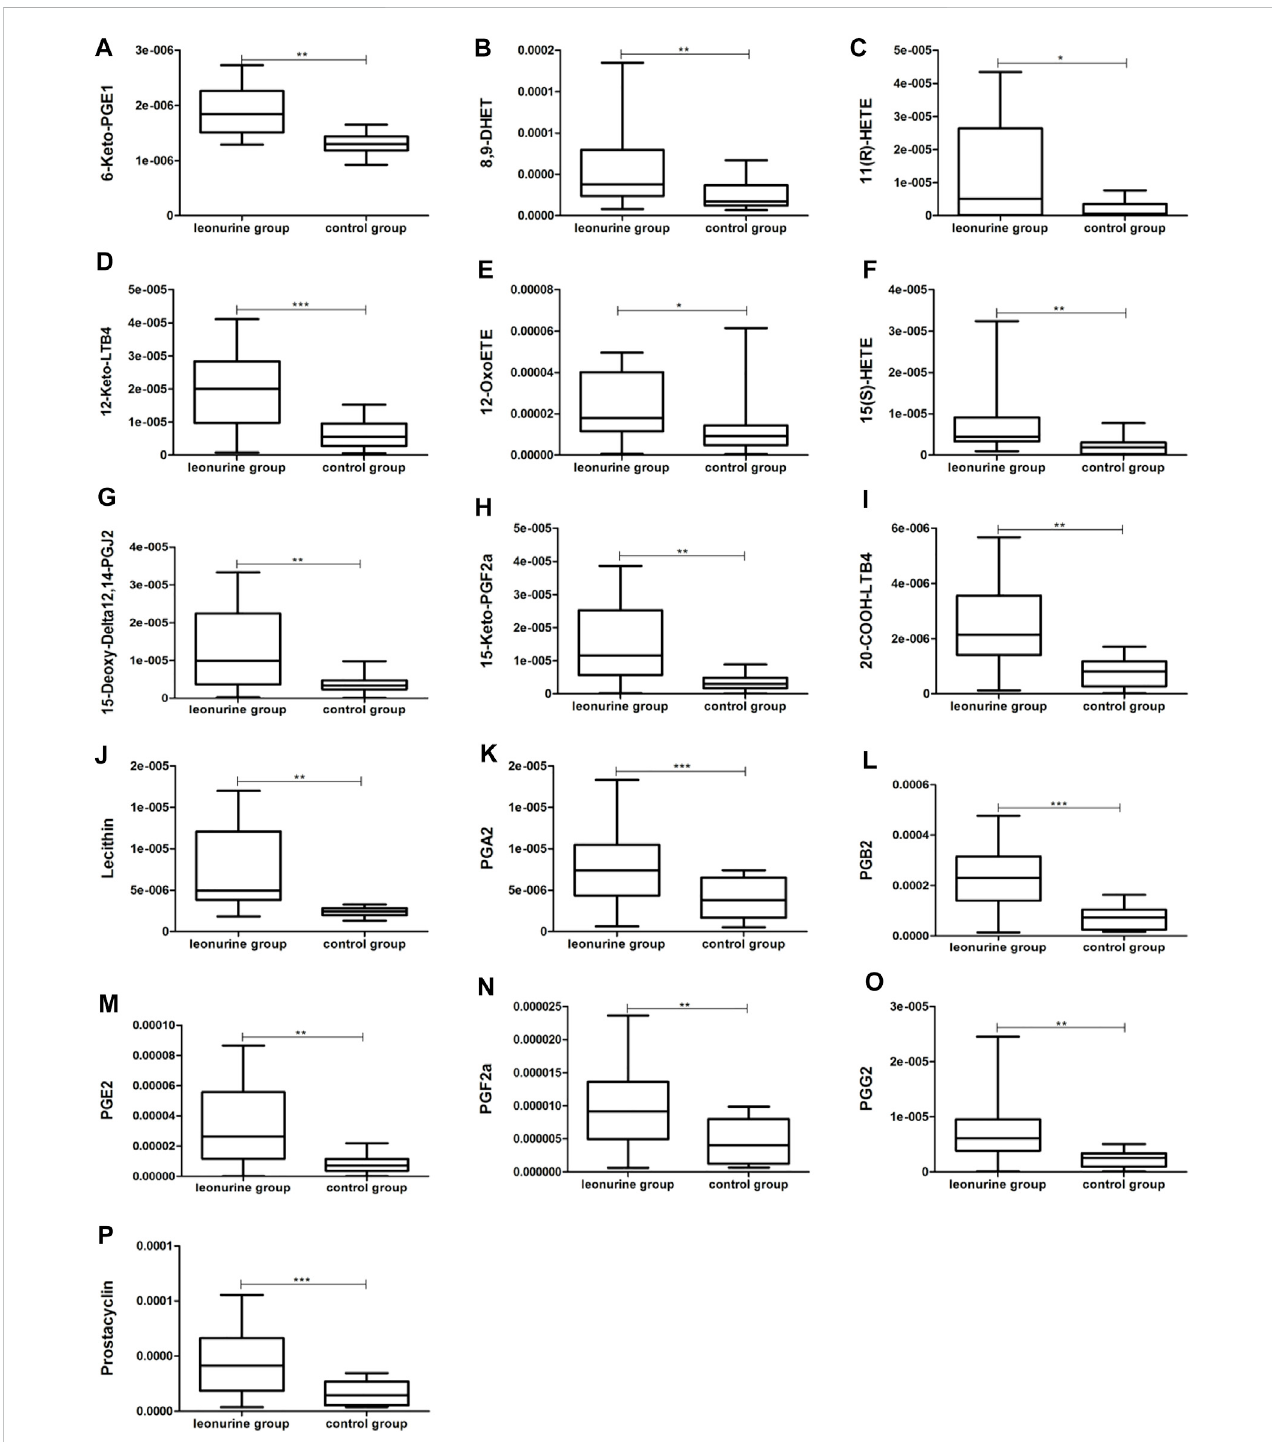
The signi fi cantly up-regulated metabolitesin moDCs with leonurine administration(HD-moDCs, n = 15). 16 metabolites as shown in theabove boxplots (A – P) were signi fi cantly up-regulated in the leonurine group than in the control